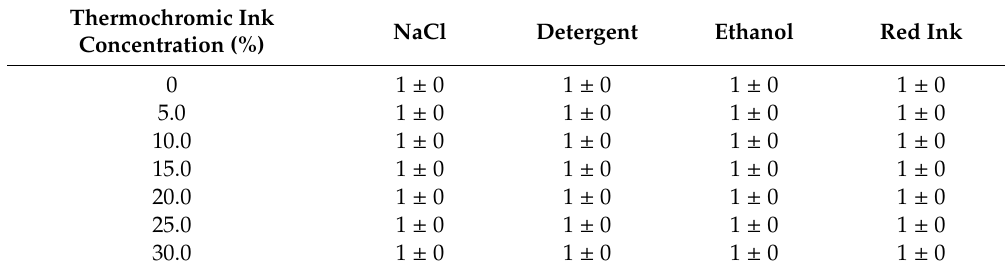
Table 5. Coating liquid resistance level. Level Finish Film Change Slightly discolored impression Slight discoloration or noticeable discoloration Obvious changes, bubbling, wrinkles, etc. Table 6. E ff ect of thermochromic ink concentration on liquid resistance level of finish film.